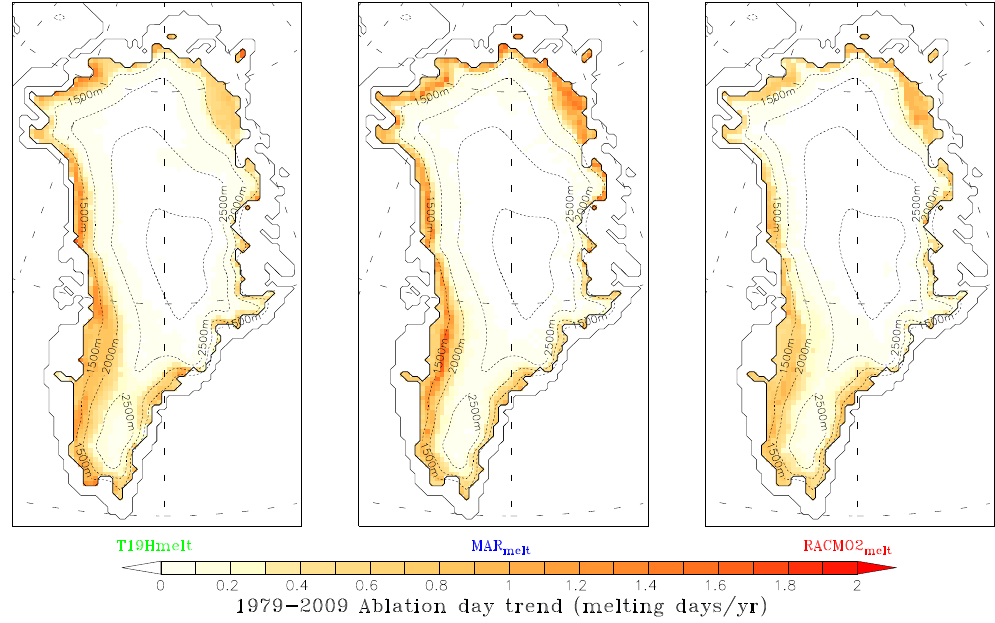
Fig. 9. Linear melt trend (in ablation daysyear − 1 ) detected by T19H melt and simulated by the models for the period 1979–2009.